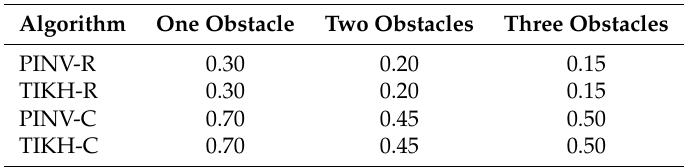
Table 1. Maximum pixel intensity value obtained from ROC curves for thresholding the reconstructed images by PINV and TIKH